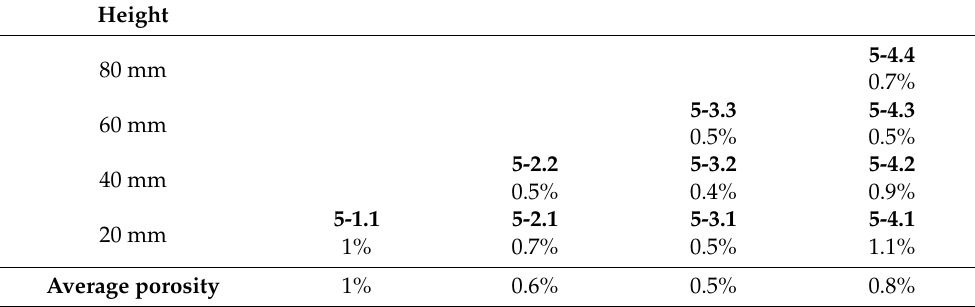
Table 5. The resulting values of the porosity of the XY